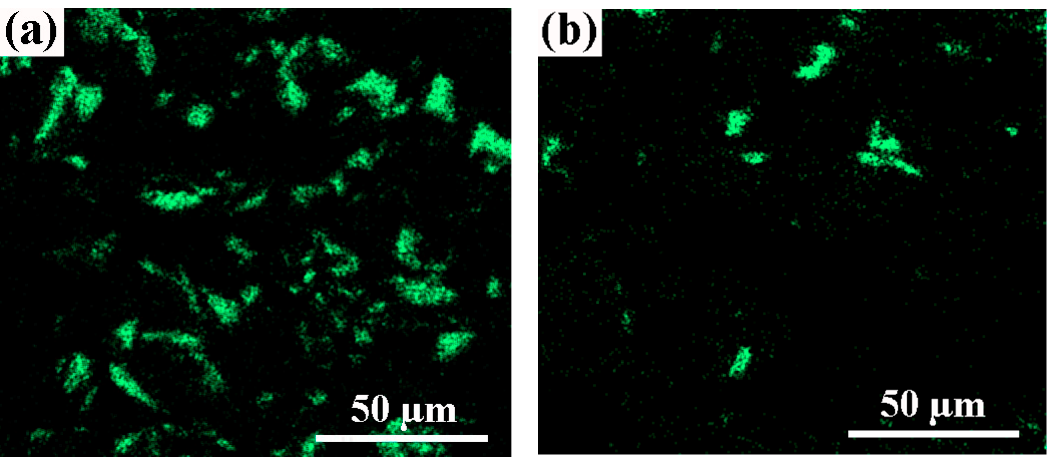
Figure 11. EDS surface scanning analysis of elemental Si on the fracture surfaces of the composite tested at temperatures of ( a ) 25 °C and ( b ) 300